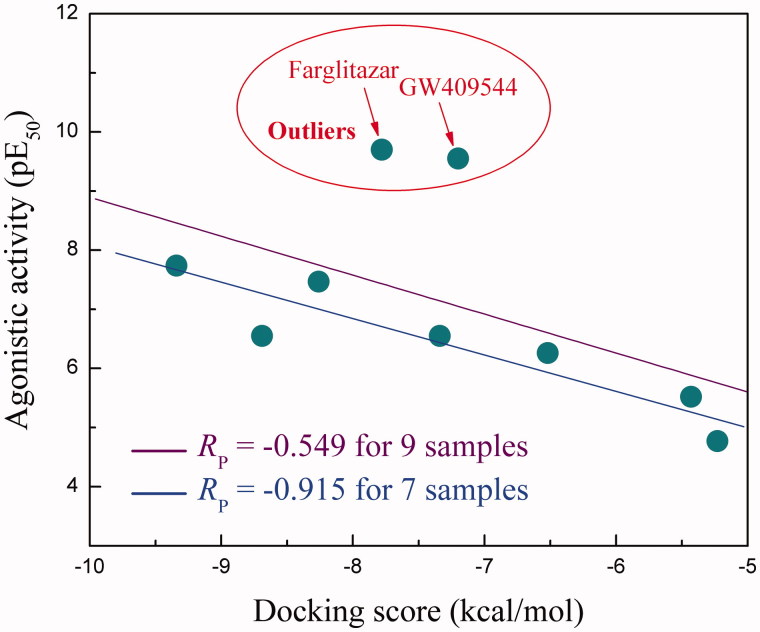
Scatter plot of agonistic activity against docking score over nine PPARγ agonists.